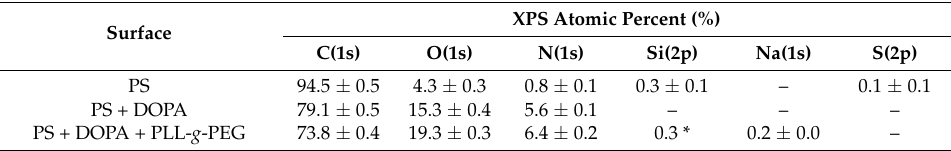
Table 1. The elemental ratios present in the build-up of the PS + DOPA + PLL- g -PEG surface.